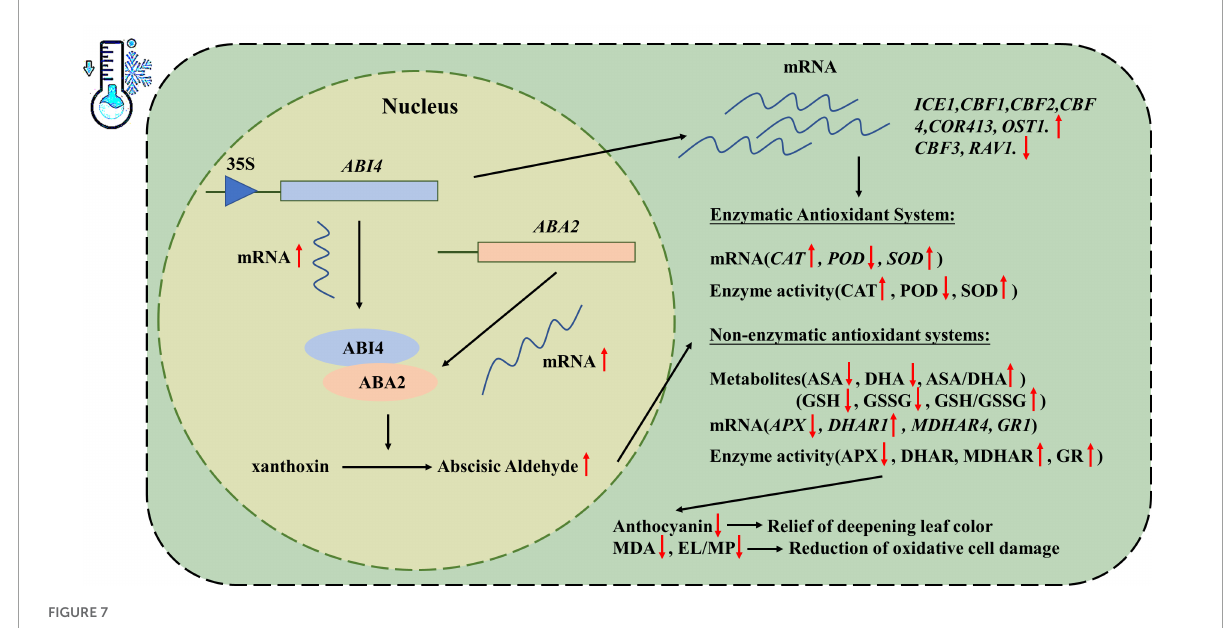
FIGURE7 Putative regulatory mechanisms of MtABI4